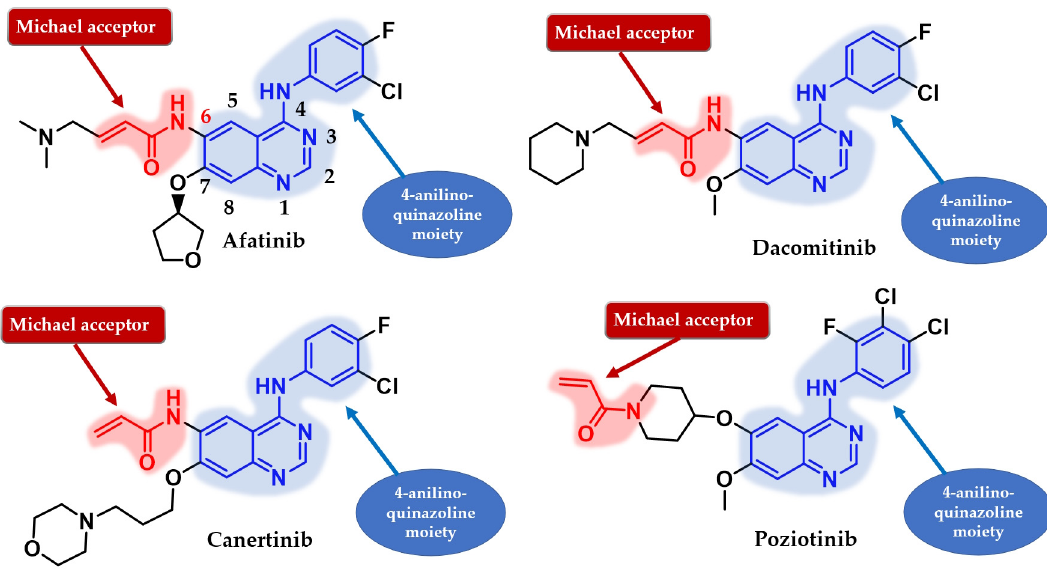
Figure 19. Chemical structure of second-generation EGFR inhibitors quinazoline derivatives